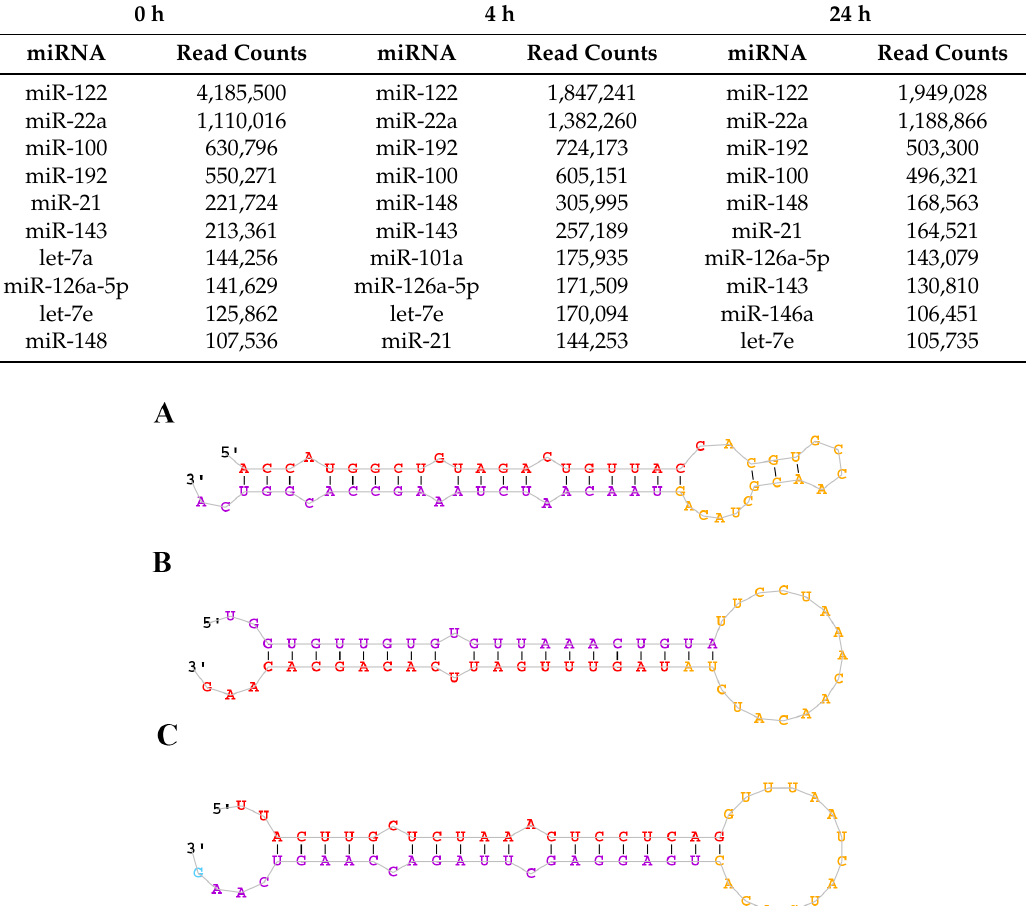
Figure 3. Predicted stem-loop secondary structures of selected M. amblycephala putative novel miRNAs. Dominant forms of the mature miRNAs are highlighted in red. ( A ) miR-novel 3; ( B ) miR-novel 55; and ( C ) miR-novel 62.